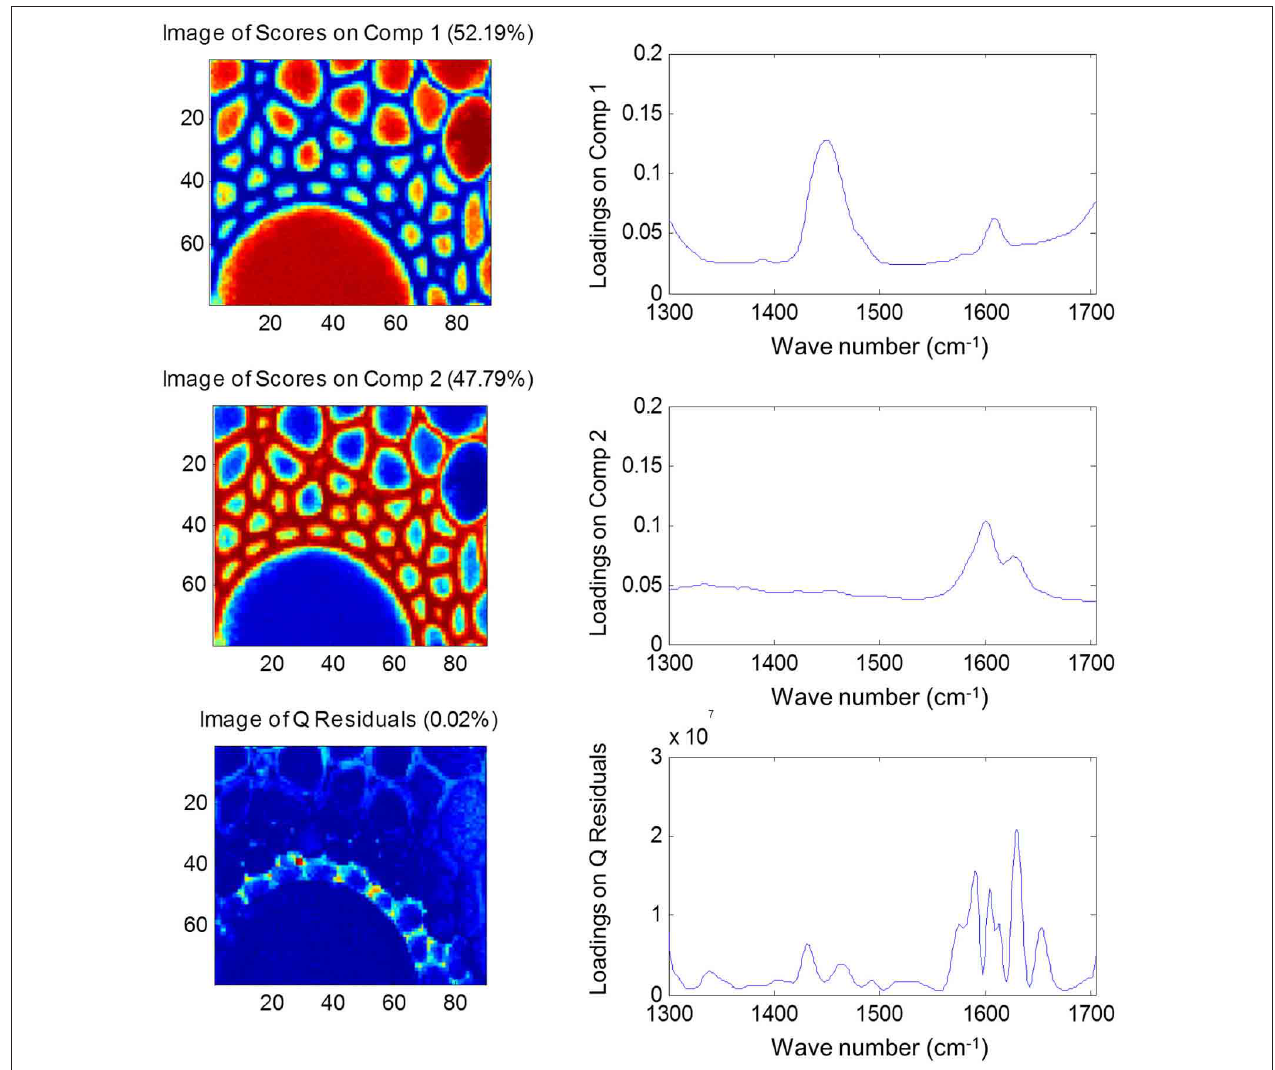
FIGURE 3 | Multiple component resolution analysis of Raman spectra maps of sections of mature maize stem internode. Score images (left) and loading plots (right) are shown for the first two components, together with the score image and loadings for the Q residuals